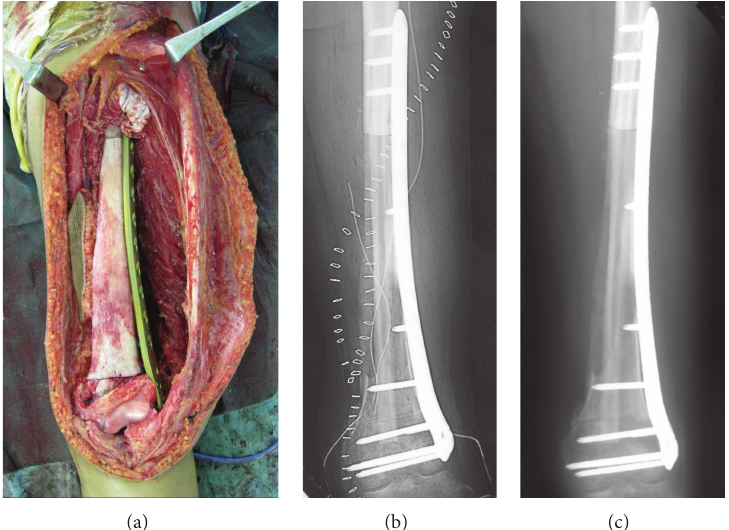
Figure 3: The composite graft was rigidly fixed to the host bone with a locking plate and screws ((a) operative photograph, (b) postoperative plain radiograph). A plain radiograph 9 months after surgery. Bone union was achieved